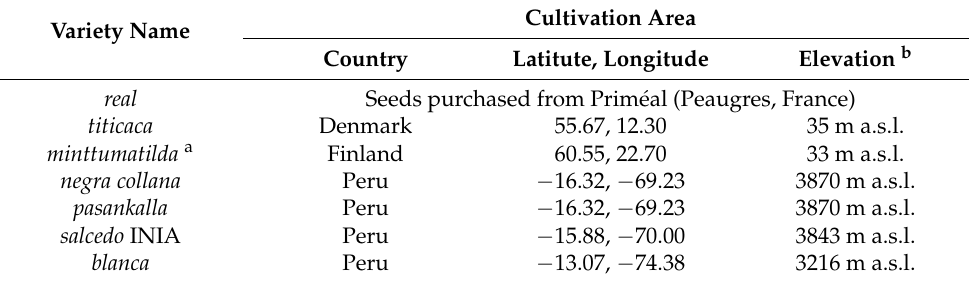
Table 1. List of the quinoa varieties used in this study. All seeds were harvested in 2017 and were obtained from different cultivation areas with the exception of real , which was commercially